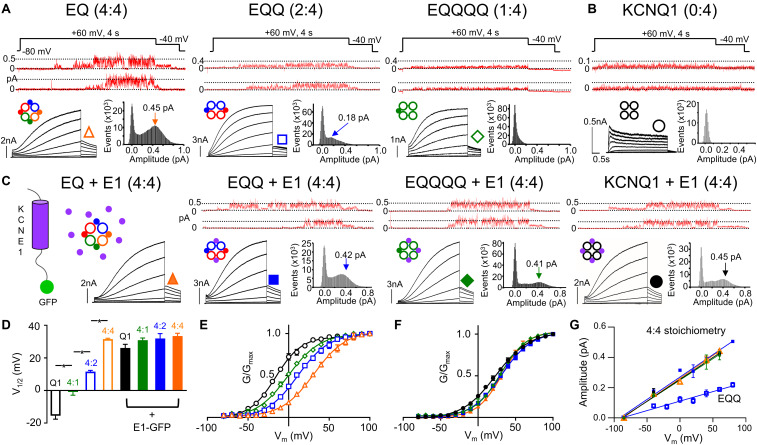
IKs channel gating depends on the stoichiometric ratio of KCNE1:KCNQ1. Representative single channel (above) and whole cell currents (below) with single channel all-points amplitude histograms of active sweeps (lower right) are shown for EQ (orange), EQQ (blue), EQQQQ (green), and KCNQ1 (black) expressed alone (A–B) or in combination with wild-type KCNE1-GFP (C, all panels). The predicted stoichiometry of KCNE1:KCNQ1 in each case is shown above. Arrows on histograms indicate the peak of the major Gaussian fit. Whole cell protocol: 4 s pulses from –80 mV to between –80 and +100 mV, followed by a repolarizing step to –40 mV for 1 s. Single channel protocol: 4 s pulses from –60 mV (–80 mV for EQQQQ) to +60 mV for 4 s, repolarized to –40 mV for 0.75 s. In A-C, topologies of expected channel Q1 and E1 complexes indicated as large hollow and small filled circles, respectively. (D) V1/2 of activation (n = 3–11; *p < 0.05) as indicated. Mean G-V plots from peak tail currents: KCNQ1 (black), EQQQQ (green), EQQ (blue), and EQ (orange) expressed alone (E) and in the presence of KCNE1 (F; filled symbols). (G) Slope conductance for each construct showing peak open amplitudes in the presence of KCNE1 (4:4 stoichiometry, EQ, EQQ, EQQQQ and KCNQ1 in the presence of KCNE1) and EQQ alone. Conductance not measured for EQQQQ or KCNQ1 alone. All error bars in this and other figures denote mean ± SE. Figure adapted from Murray et al. (2016), Figures 1–3. Reproduced with permission of CC-BY 4.0.